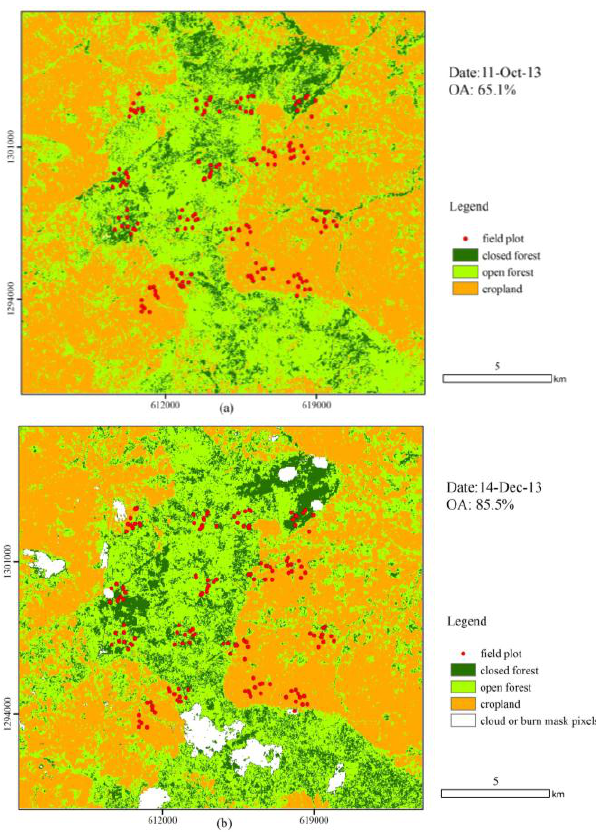
Figure 5. Land cover classifications based on (a) 11-Oct-13 image and (b) 14-Dec-13 image.